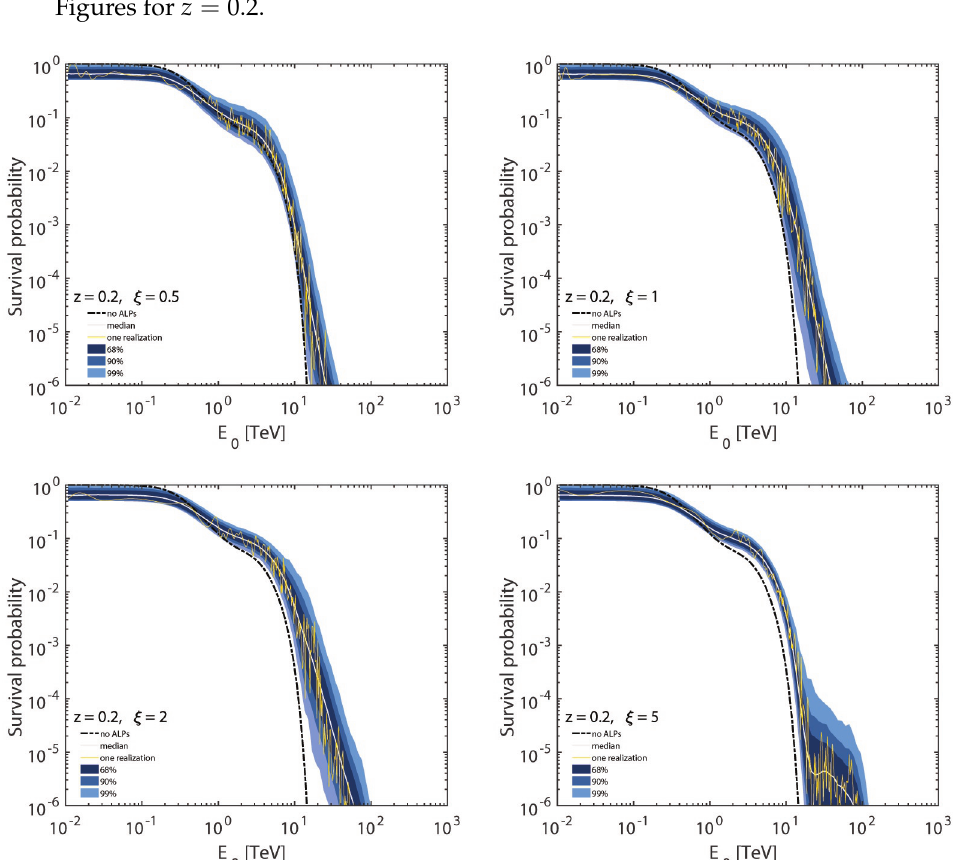
Figure 20. Same as Figure 17 apart from z = 0.2. (Credit